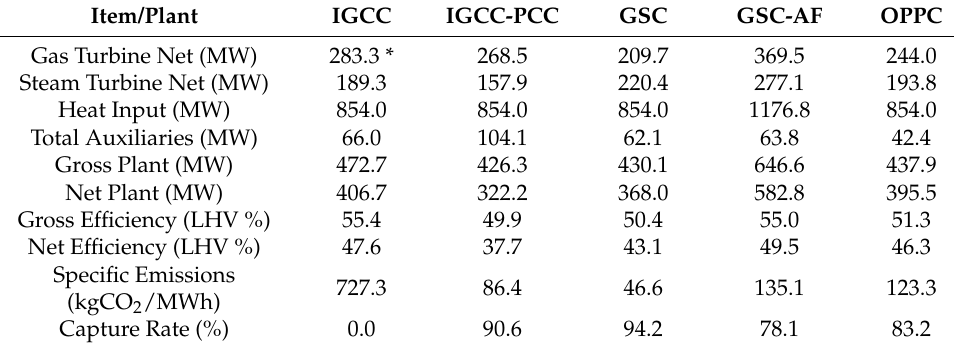
Table 6. Power plant performance